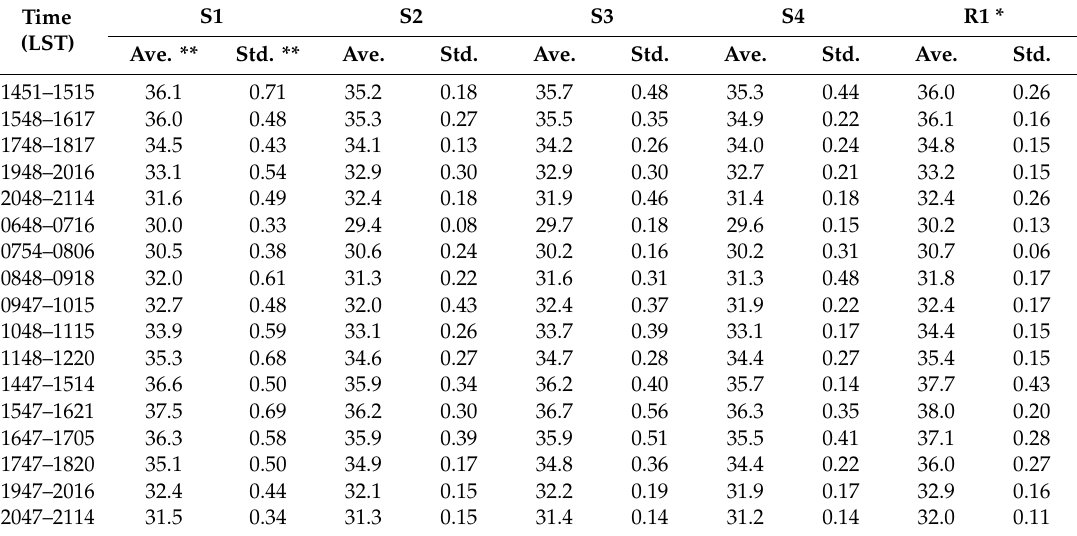
Table 4. Statistics of air temperatures for each section during the BBMEX